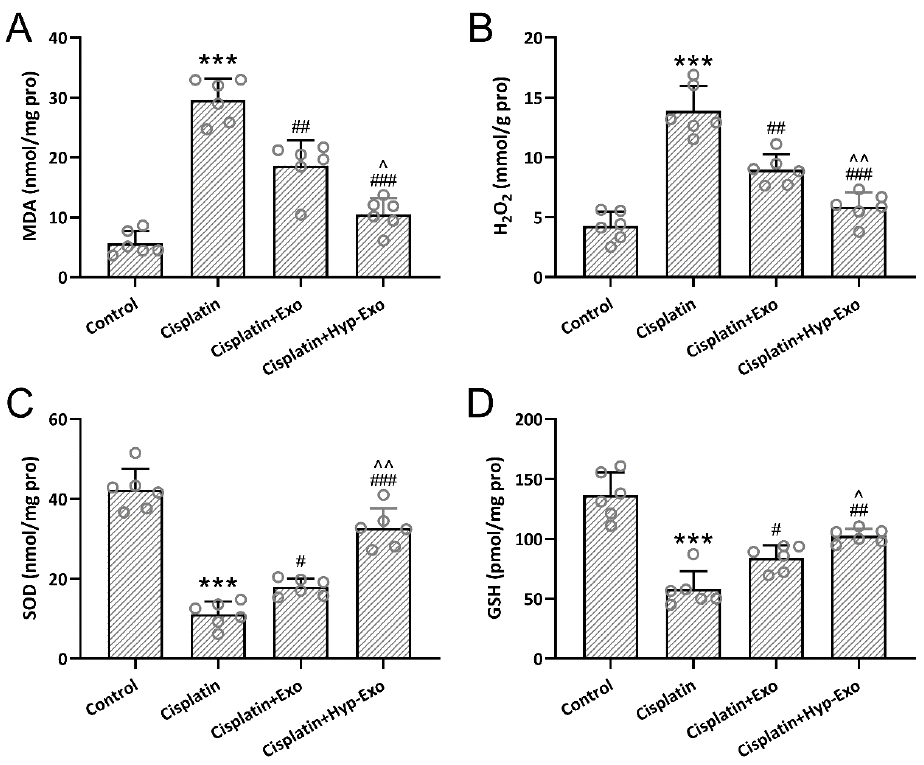
Figure 7. HypBMSC-Exo ameliorated cisplatin-induced oxidative stress in the middle turns of the cochlea. The content of malondialdehyde (MDA) ( A ), hydrogen peroxide (H 2 O 2 ) ( B ), superoxide dismutase (SOD) ( C ), and glutathione (GSH) ( D ) in the middle turns of the cochlea. The data were shown with mean ± SD. Eight mice were used for each group. *** p < 0.001 compared to control, # p < 0.05, ## p < 0.01, ### p < 0.001 compared to Cisplatin, ˆ p < 0.05, ˆˆ p < 0.01 compared to Cisplatin + Exo. One-way ANOVA followed Tukey’s multiple comparisons